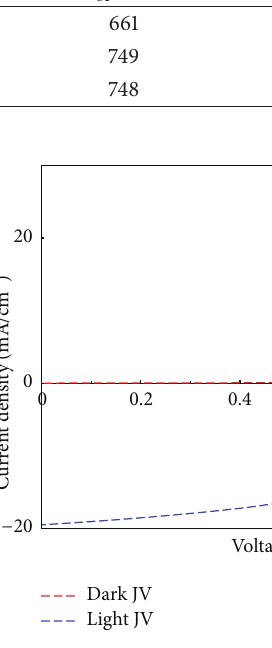
Figure 3: Simulated light and dark current-voltage